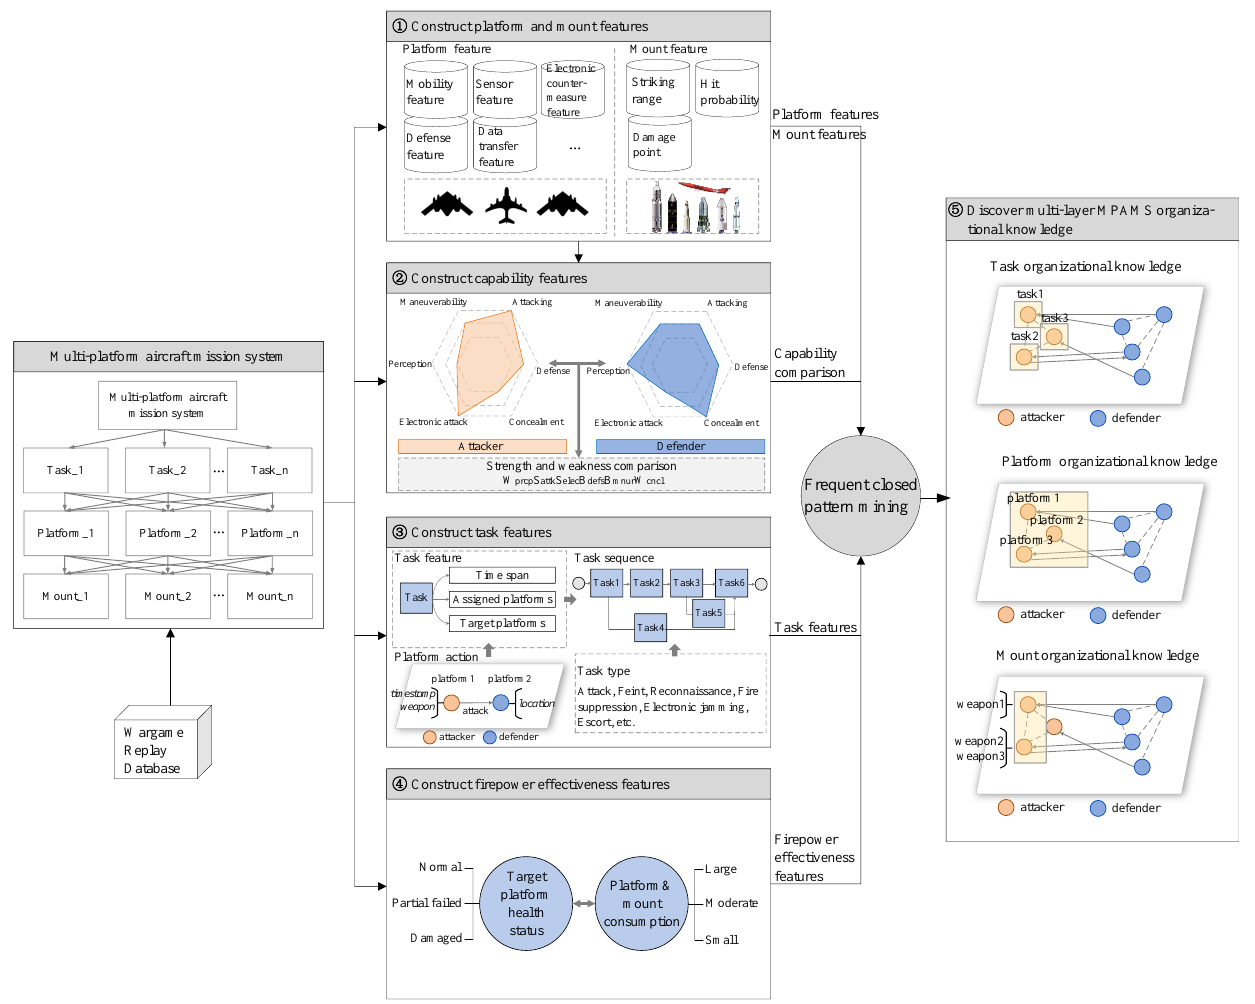
Figure 4. Framework of the MPAMS organizational knowledge discovery. (W: weak, B: balance, S: strong in step 2).